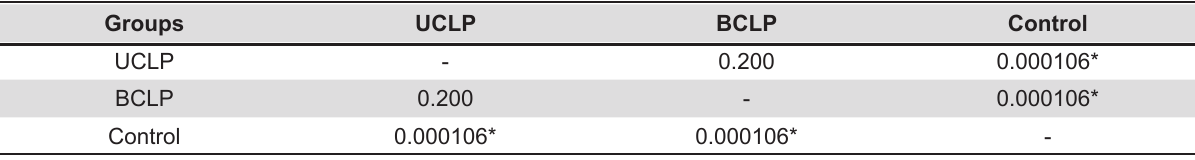
Table 2- Results of t test for the studied variables